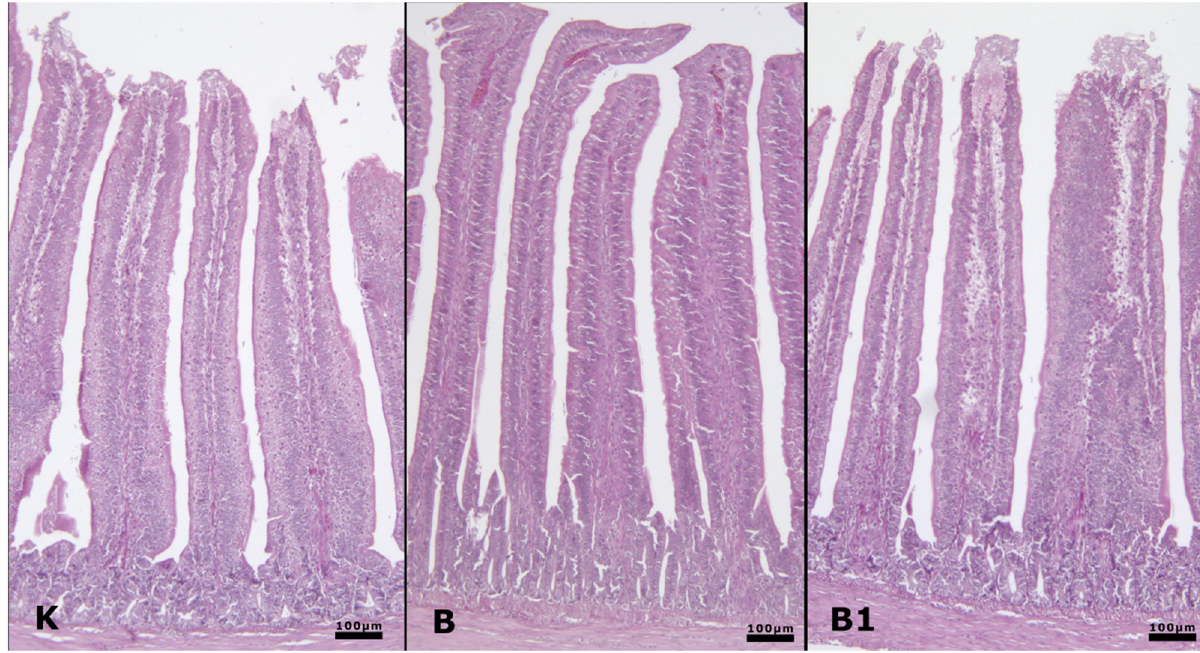
Figure 1: Microscopic view of the jejunal mucosa in the experimental groups. Longer villi are seen in Bor 0.5 group ( B ) and Bor 1 group ( B1 ) compared to the control group ( K ) . HE. Bar = actual length.